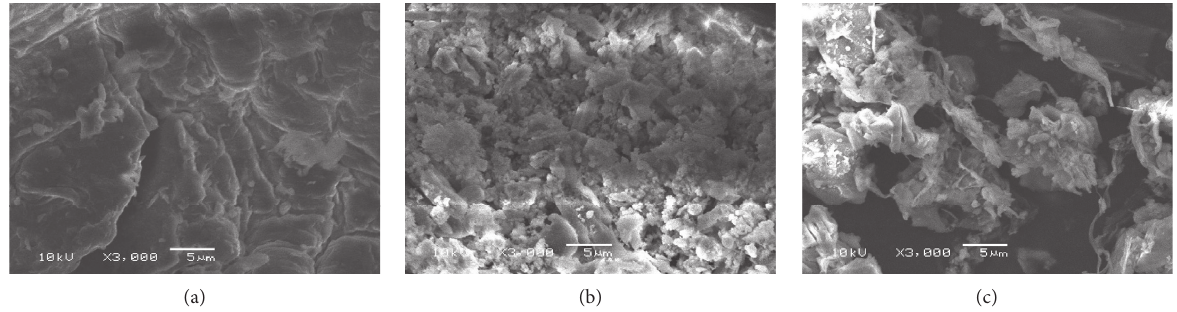
Figure 2: SEM images of chitosan/modified chitosan: (a) chitosan; (b) Ch-TQ; (c) Ch-TAMPy.